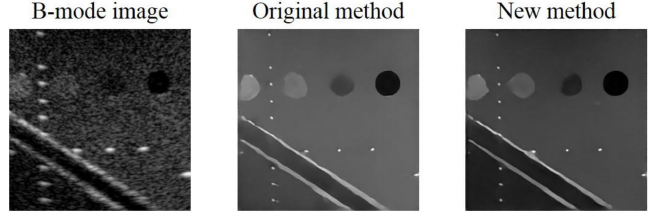
Figure 12. B-mode image and the reconstructed echogenicity maps of the models applied the two normalization